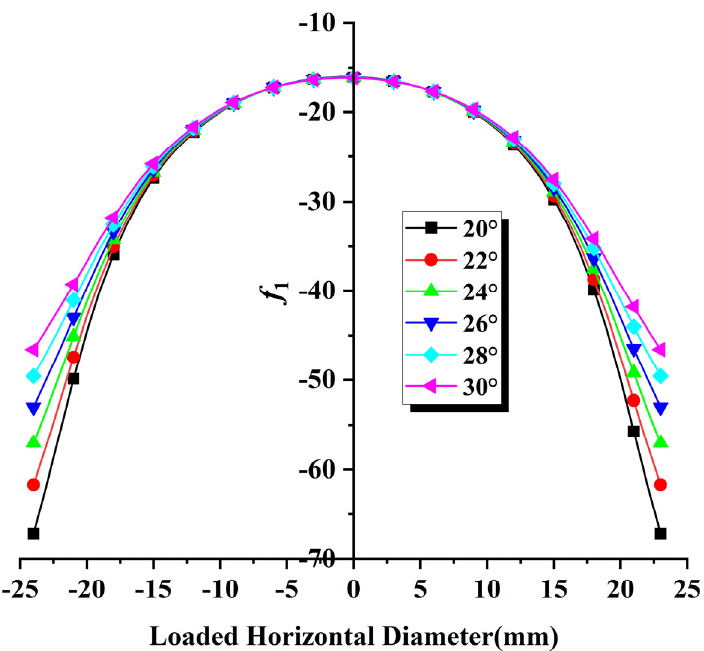
Figure 8. Non-dimensional Griffith decision conditions along loaded diameter.